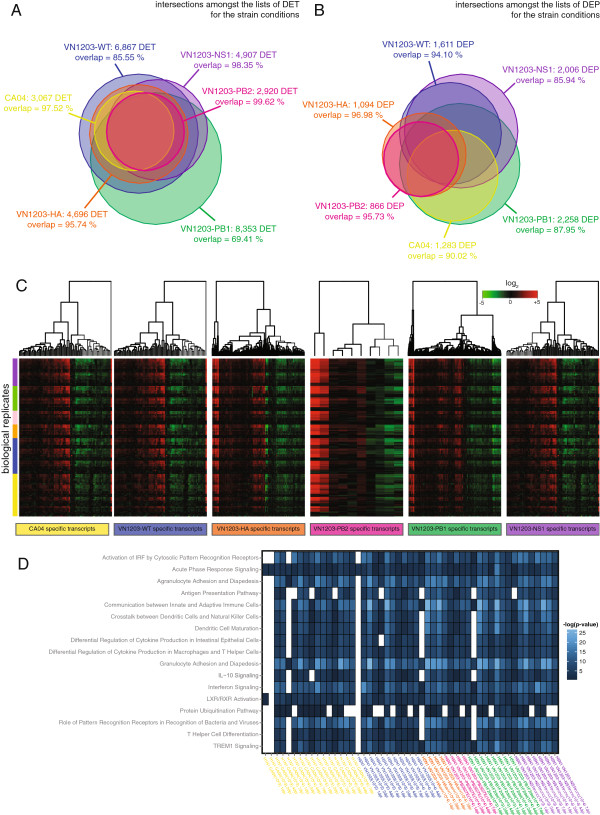
Intersections between the lists of DET and DEP for the strain conditions. (A) and (B) Proportional Euler-diagrams showing the intersections between the lists of differentially expressed transcripts and proteins identified for the strain conditions. Proportional Euler-diagrams visually represent the cardinalities of sets and intersection sets of differentially expressed transcripts or proteins by area-proportional circle graphics. Each list of DE transcripts or proteins is then represented by a circle with a diameter proportional to the cardinality of the list and the overlaps between the circles are proportional to the cardinality of the intersections between the lists. For each strain condition the number of transcripts or proteins found as DE in the host response is indicated as well as the degree of overlap — quantified as the percentage of transcripts or proteins also found as differentially expressed in another condition. (C) Heatmap of the transcriptomic expression values, ratioed to mock-infected samples, for each infected sample. The heatmaps have been restricted to the lists of transcripts found as specific for each viral strain and the different subsets of transcripts specific are indicated. For each set of specific transcripts, hierarchical clustering have been performed and represented using dendrograms. Biological samples have been ordered by strain conditions, sorted by inoculation concentrations and then by increasing days post-infection. (D) Heatmaps showing the statistical over-representation of the canonical pathways based on the lists of transcripts found as differentially expressed (compared to the mock-infected conditions) for each of the 51 biological conditions. This heatmap has been restricted to only display the top canonical pathways over-represented across all the dataset.